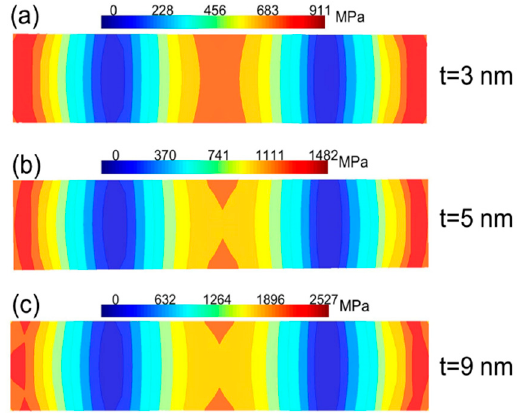
Figure 5. Contour plot (top view of graphene beam) of von Mises stress for the NEM switch A, with different graphene beam thicknesses of t = 3, 5, and 9 nm.